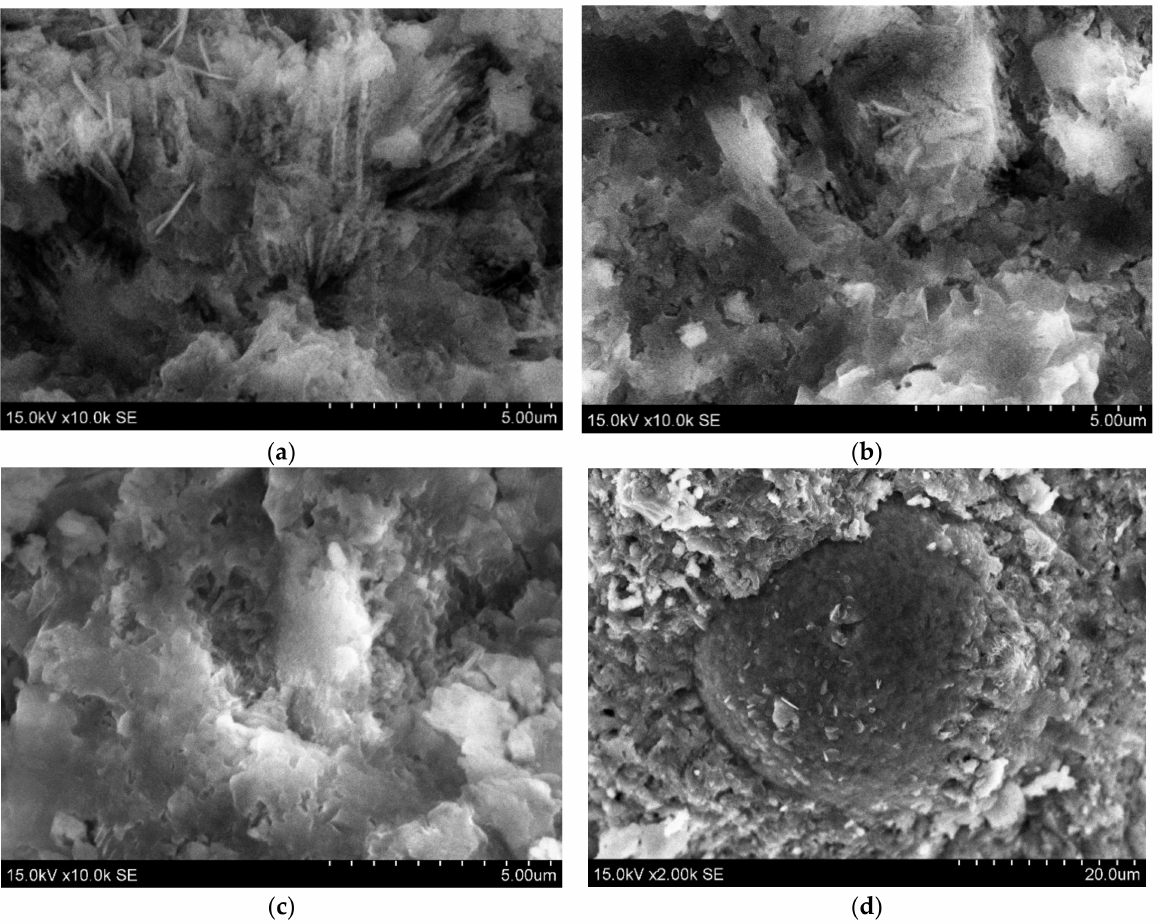
Figure 7. The morphologies of hardened cement paste at 28 days of hydration: ( a , b ) 50TW/50WW sample; ( c , d ) Z50TW/ 50WW